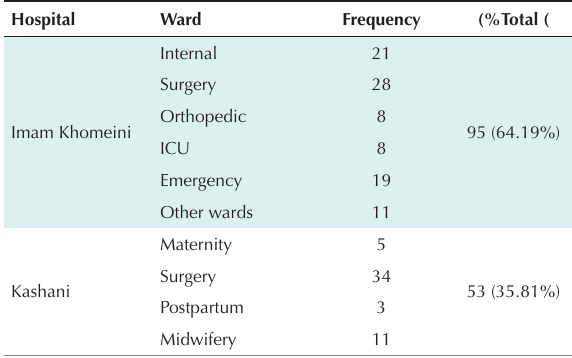
Table 2. Frequency of Complications After Transfusion Based on the Inpatient Ward